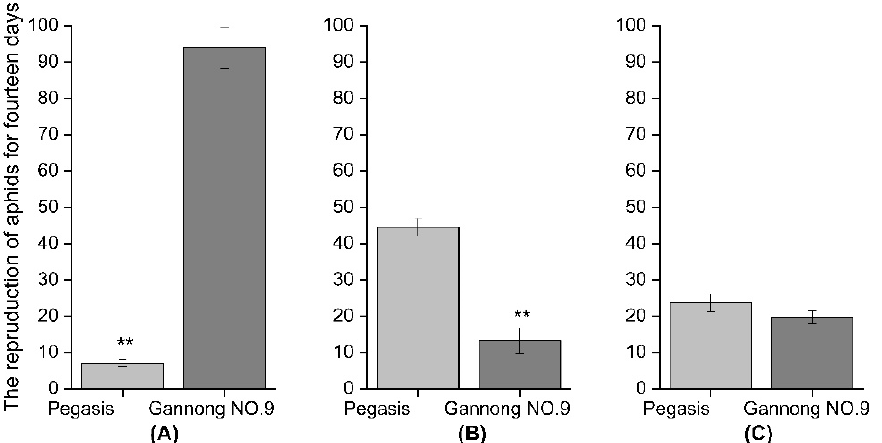
Figure 3. The number of offspring of ( A ) cowpea aphid (CPA), ( B ) pea aphid (PA), ( C ) spotted aphid (SAA) on the alfalfa cultivars of Pegasis and Gannong NO.9 after fourteen days (** Indicates that the difference is significant p < 0.05).